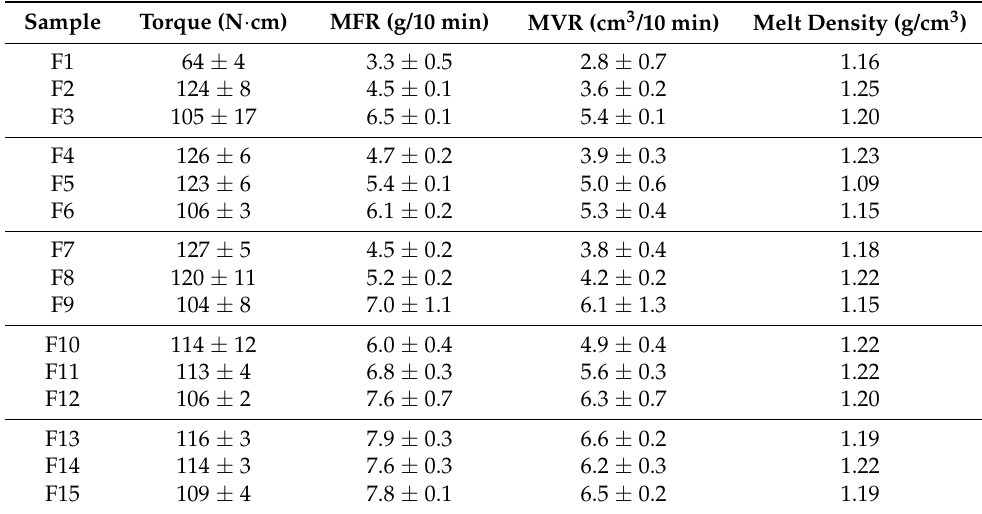
Table 2. Torque and melt flow results of different